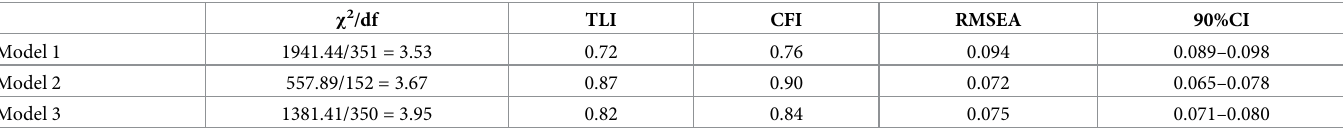
Table 2. Fit indices of the three tested confirmatory factor analyses models of the Dissociative Experience Scale